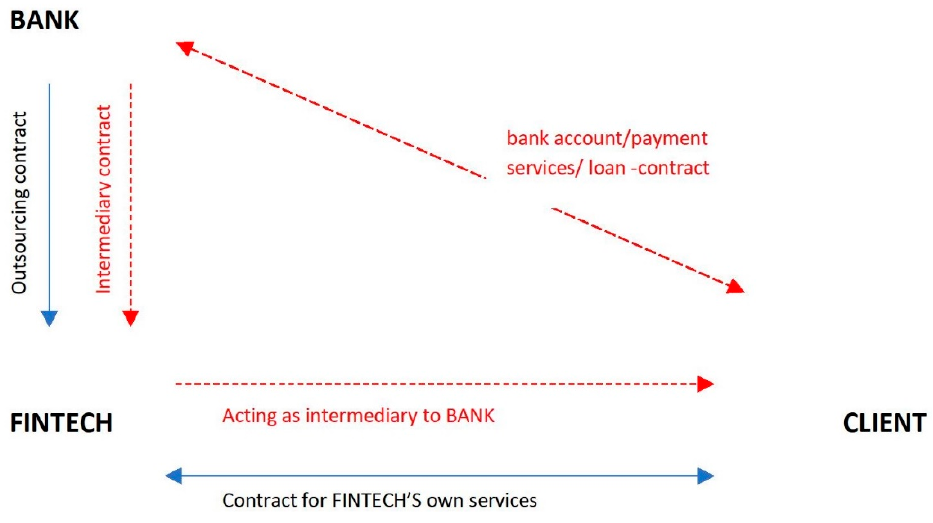
Figure 1. “License lending” model.